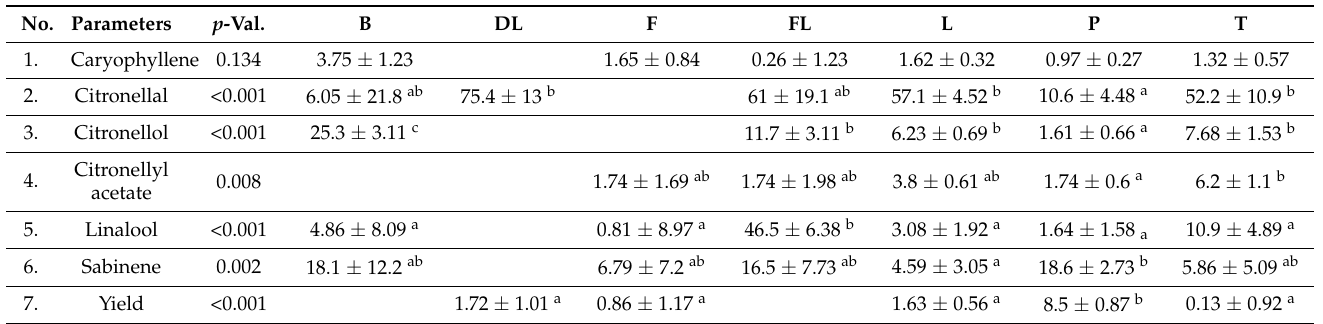
Table 6. Meta-analysis of yield and main components of kaffir lime essential oil in response to plant part (mean ± standard error).